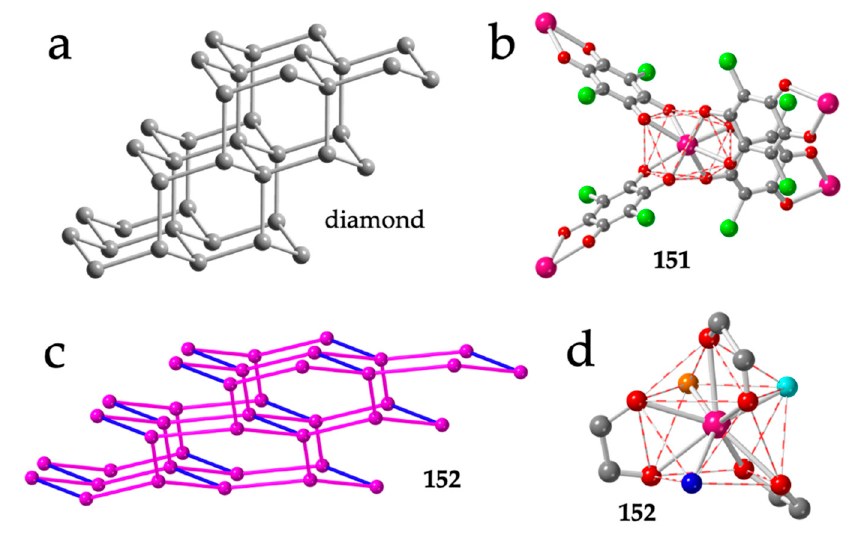
Figure 18. ( a ) Structure of diamond. ( b ) Tetrahedral disposition of the four anilato ligands around the Y(III) ions in compound 151 . ( c ) Distorted adamantane structure in compound 152 . Pink and blue lines represent the anilato and formate bridges, respectively. ( d ) Coordination geometry around the Tb(III) ion in compound 152 . Colour code: Ln = pink, Cl = green, C = grey, O anilato = red, O water = dark blue, O dmf = orange and O formate = light blue.